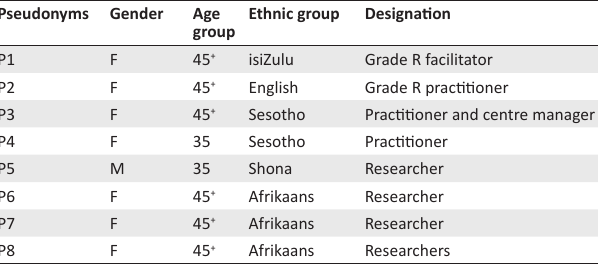
TABLE 1: Biographical details of the research participants. Pseudonyms